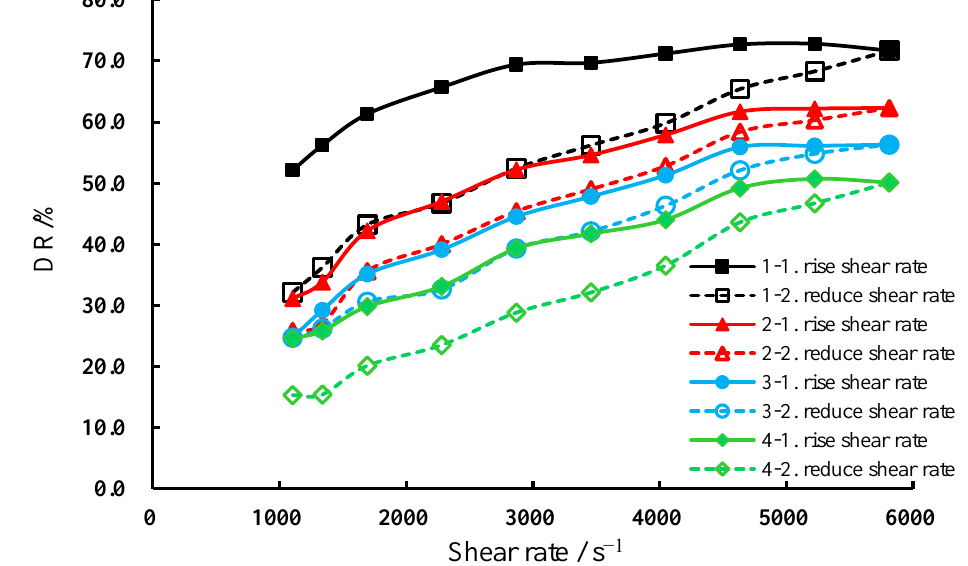
Figure 4. Variations of drag-reduction rate with shear rate from repeated experiments.